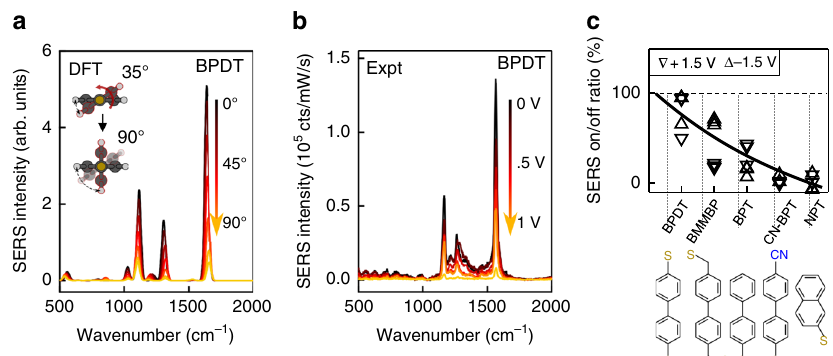
Fig. 3 Comparison of Raman vs twist θ in theory and experiment. a DFT calculations show decrease in Raman intensity with increasing dihedral angle for BPDT. b Experimental reduction in SERS intensity as voltage increases from 0 V to 1 V. c SERS intensity reduction quanti fi ed as ratio at ±1.5 V vs 0 V